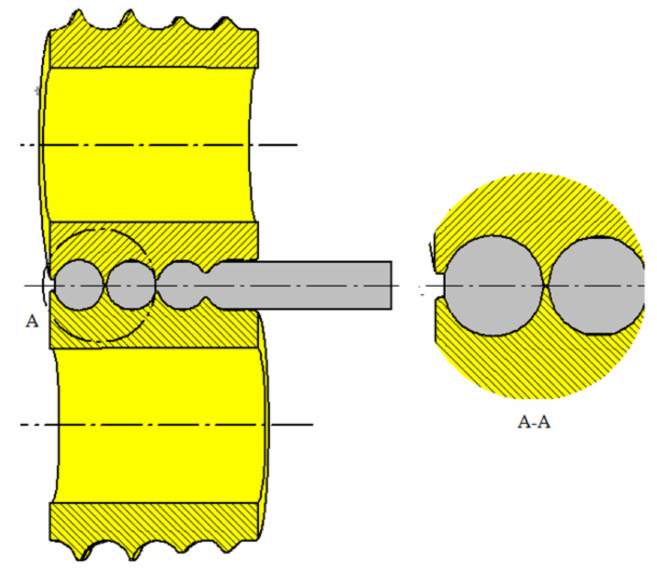
Figure 7. Ball splitting diagram on first type tools.